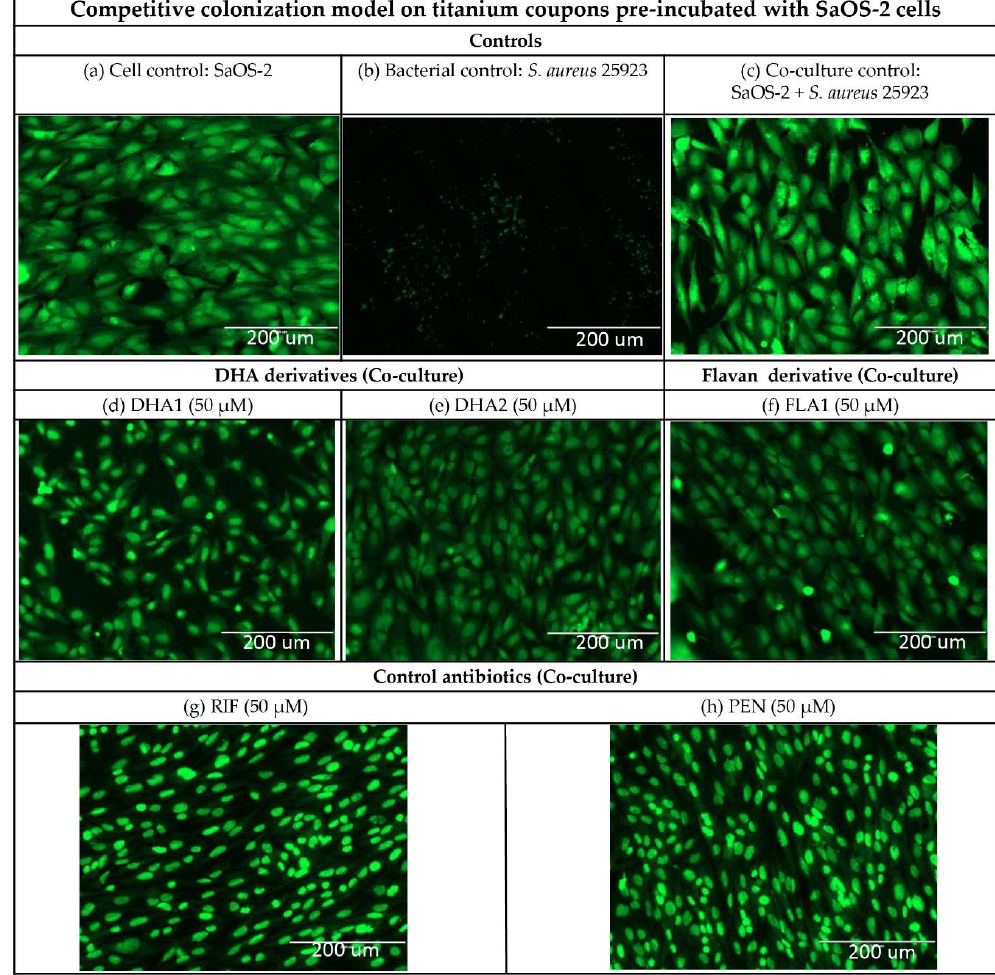
Figure 7. Representative fluorescence microscope images of titanium coupons treated under different conditions in a competitive colonization model with cellular pre-coating. Upper row of the images (Figure 7a–c) correspond to the controls: ( a ) titanium covered by 10 5 human cells / mL (cell control); ( b ) titanium covered by 10 4 CFU / mL of S. aureus ATCC 25923 (bacterial control), and ( c ) 10 4 CFU / mL of S. aureus ATCC 25923 and 10 5 human SaOS-2 cells / mL (co-culture control). Middle row of images (Figure 7d–f) correspond to titanium coupons with the two DHA derivatives ( d ) DHA1 and ( e ) DHA2 , and the flavonoid derivative ( f ) FLA1, all added at a concentration of 50 µ M and co-cultured with S. aureus ATCC 25923 and 10 5 human SaOS-2 cells / mL. The bottom row of images (Figure 7g,h) are representative images of titanium coupons coated with the two control antibiotics ( g ) RIF and ( h ) PEN , all added at a concentration of 50 µ M and co-cultured with 10 4 CFU / mL of S. aureus ATCC 25923 and 10 5 human SaOS-2 cells / mL. The samples were stained with acridine orange (BD Diagnostics, Sparks, MD,